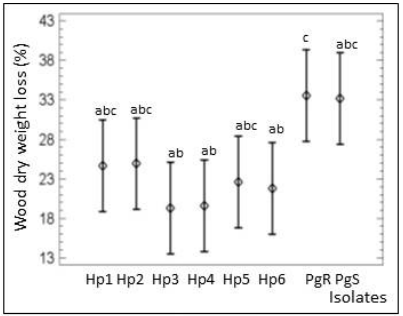
Figure 7. Average loss (%) of dry weight from Norway spruce wood after 6 months of decomposition, caused by six H. parviporum and two Finnish P. gigantea isolates (Tukey test, p α = 0.05) ( ˙Z ó łciak et al. [62]). The di ff erent letters (a, b, c) above the bars indicate statistically di ff erent groups (significance level at p -value < 0.05). Share of the same letter between groups (bars) indicates lack of statistical